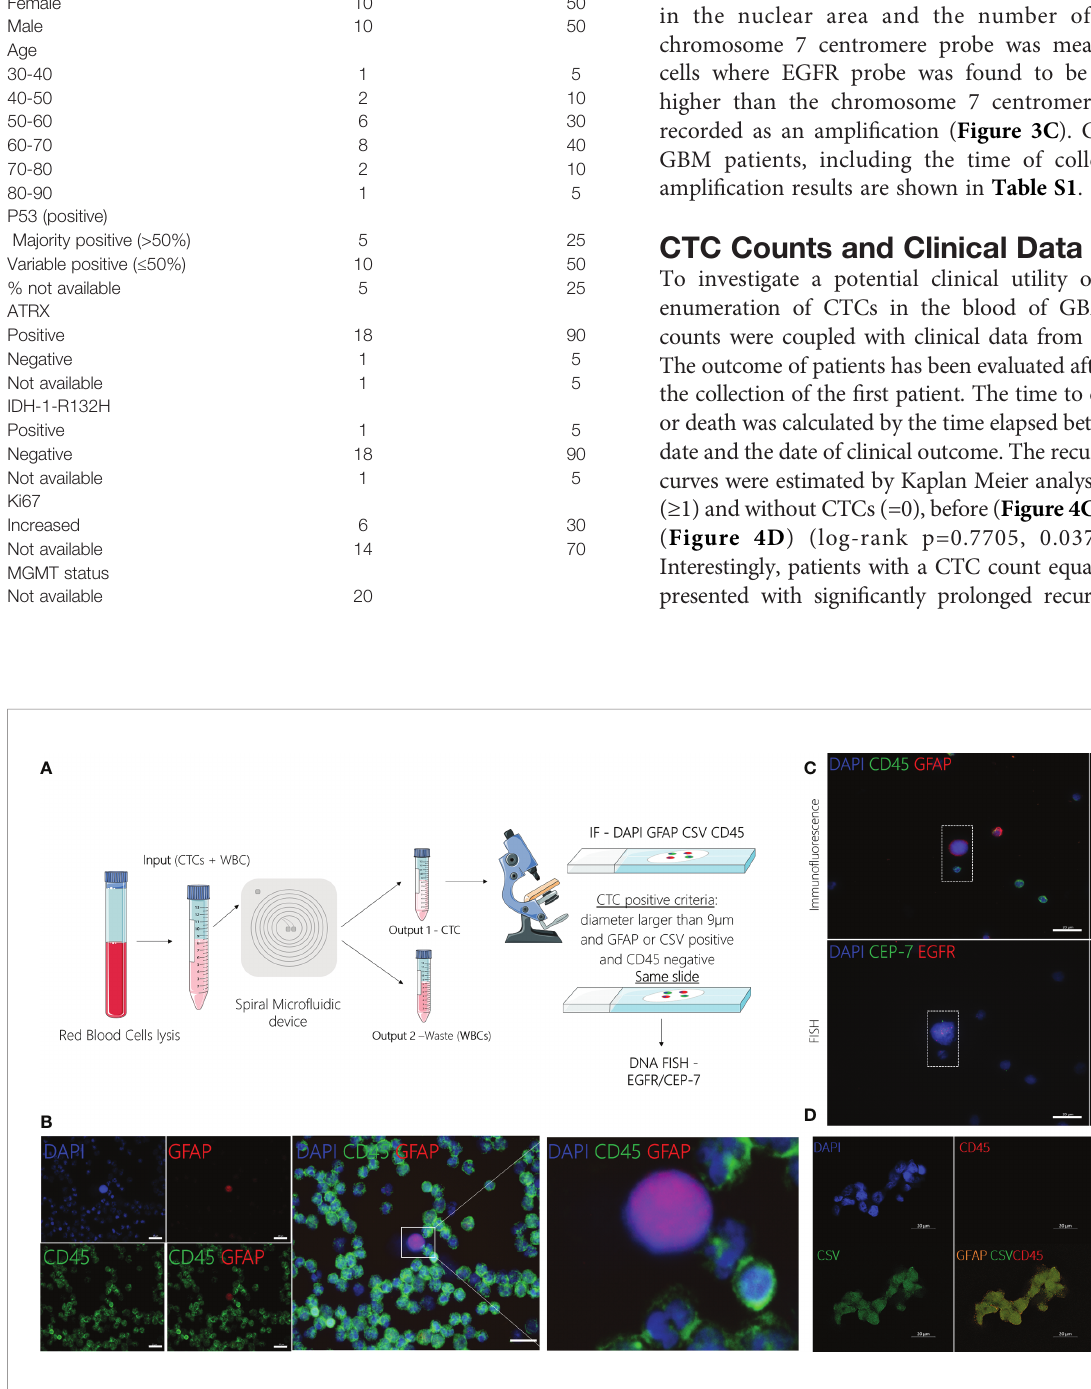
FIGURE 3 | (A) Schematic representation of CTC isolation using the spiral micro fl uidic device and characterization using IF (GFAP/CSV/CD45) and FISH (EGFR ampli fi cation). (B) Representative image of CTC characterization using immuno fl uorescence targeting GFAP (red), CD45 (green) and DAPI (blue), scale bar = 20µm. (C) Characterization of putative CTC at a molecular level using DNA FISH to detect EGFR (red) copies and CEP-7 (green). (D) Characterization of putative CTC cluster using immuno fl uorescence targeting GFAP (orange), CSV (green), CD45 (red) and DAPI (blue), scale bar =